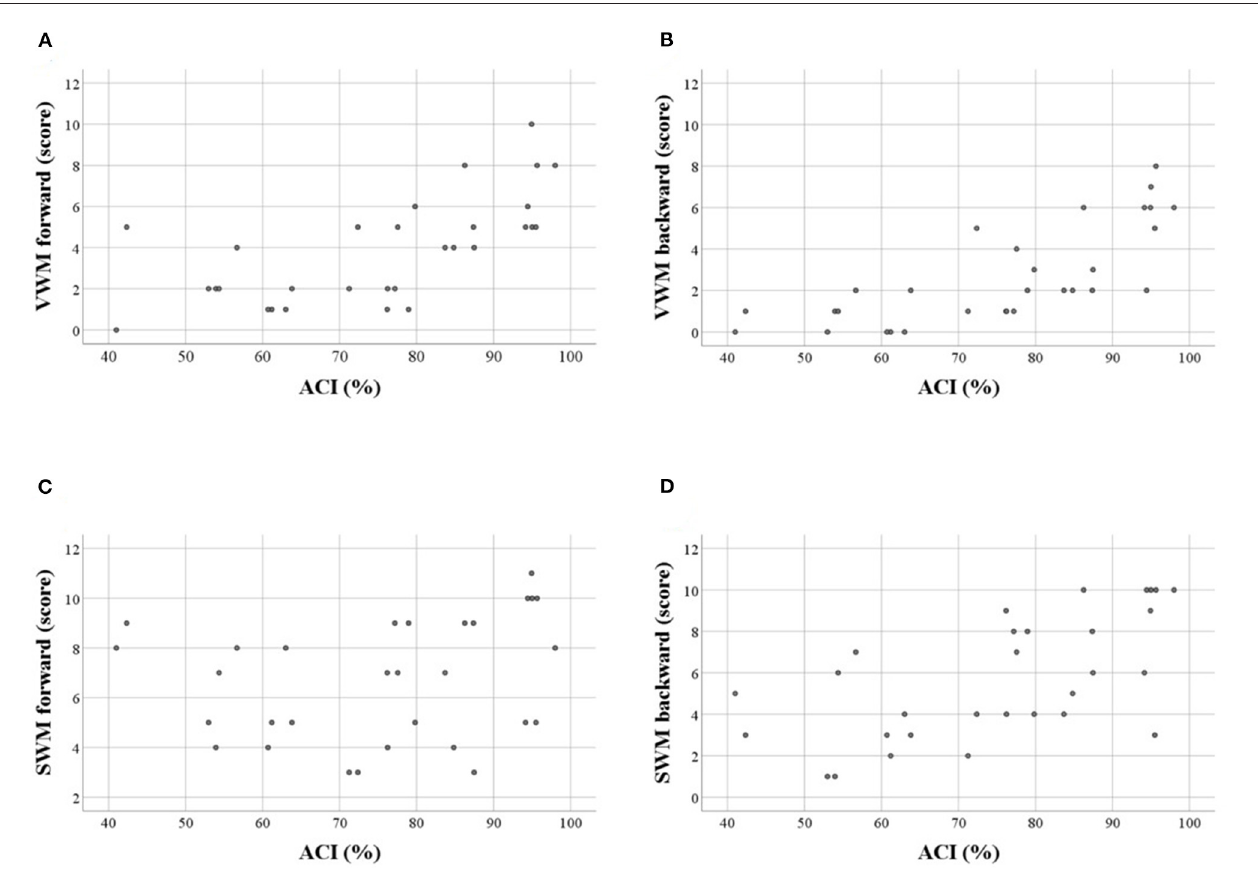
FIGURE 3 | Scatter plots illustrating correlations between WM scores and auditory comprehension index (ACI, in %) in particular tasks: (A) VWM forward, (B) VWM backward, (C) SWM forward, (D) SWM backward. Significant correlations were observed for A,B,D (see also Table 5 ). Similar relationships were observed for WM spans.